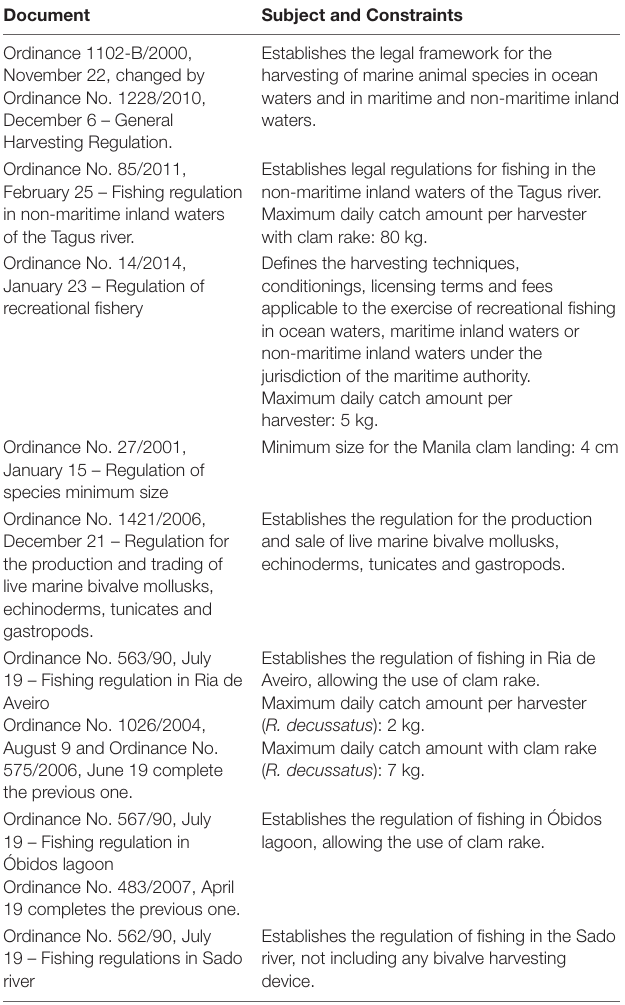
TABLE 1 | Summary of the main legal documents regulating Manila clam harvesting in